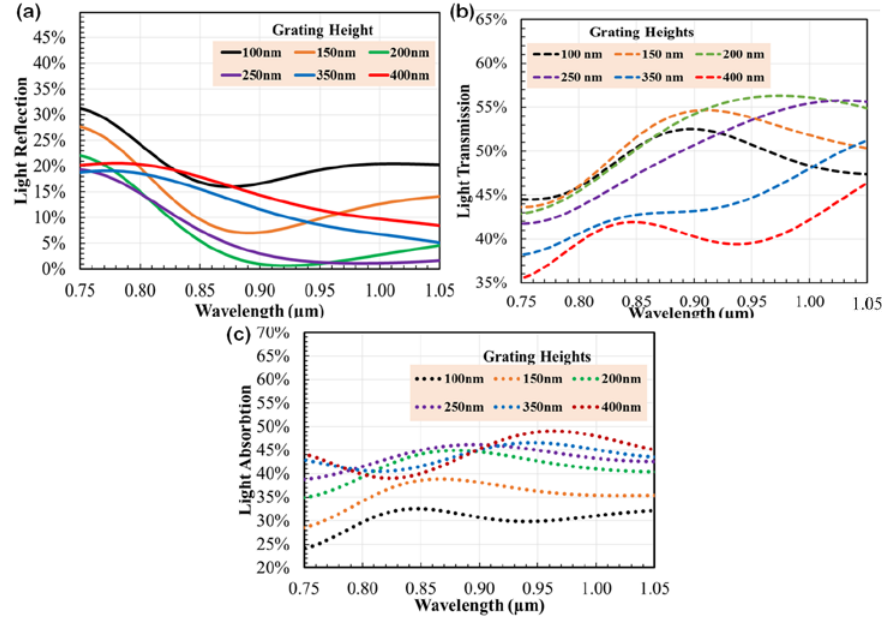
Figure 6. Observation of light reflection ( a ), transmission ( b ), and absorption ( c ) spectra for a trapezoidal-shaped nano-grating structure. The aspect ratio for the trapezoidal structure was 0.5.